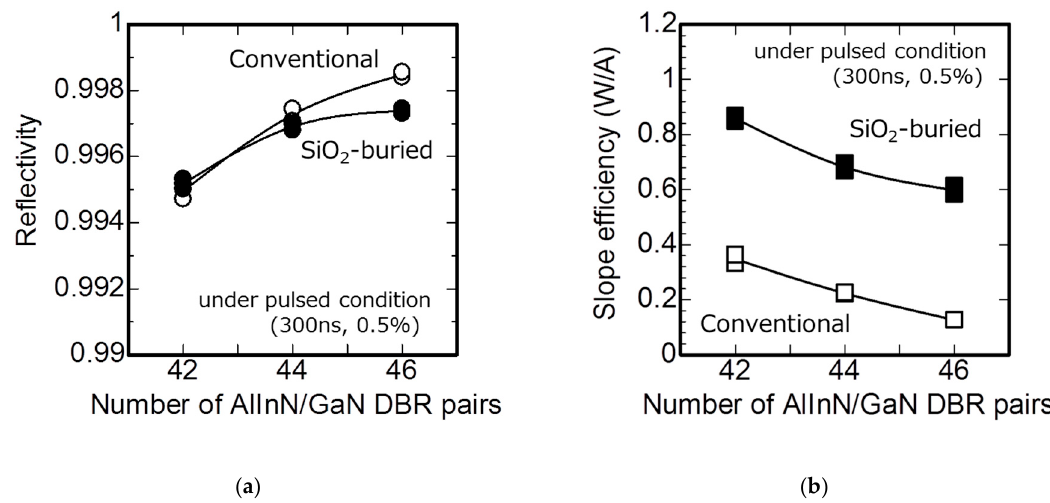
Figure 3. ( a ) Reflectivity of front mirror as a function of the number of AlInN/GaN DBR pairs. ( b ) Slope efficiency under pulsed conditions as a function of the number of AlInN/GaN DBR pairs. The open and closed symbols indicate the results obtained from VCSELs with a conventional SiO 2 aperture and a SiO 2 -buried lateral optical confinement structure, respectively.